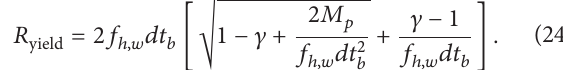
3 /6 = 900 ⋅ 0.0056 3 /6 = 26.3 ( 𝑀 𝑝 = 𝑓 𝑦 𝑑 eff = 14.5 kN, and the corresponding failure Board panel, 𝑅 embed loads for loading perpendicular to grain, 𝑅 = 11.5 kN. The failure load with respect to the and 𝑅 embed embedment strength of the steel plate is 𝑅